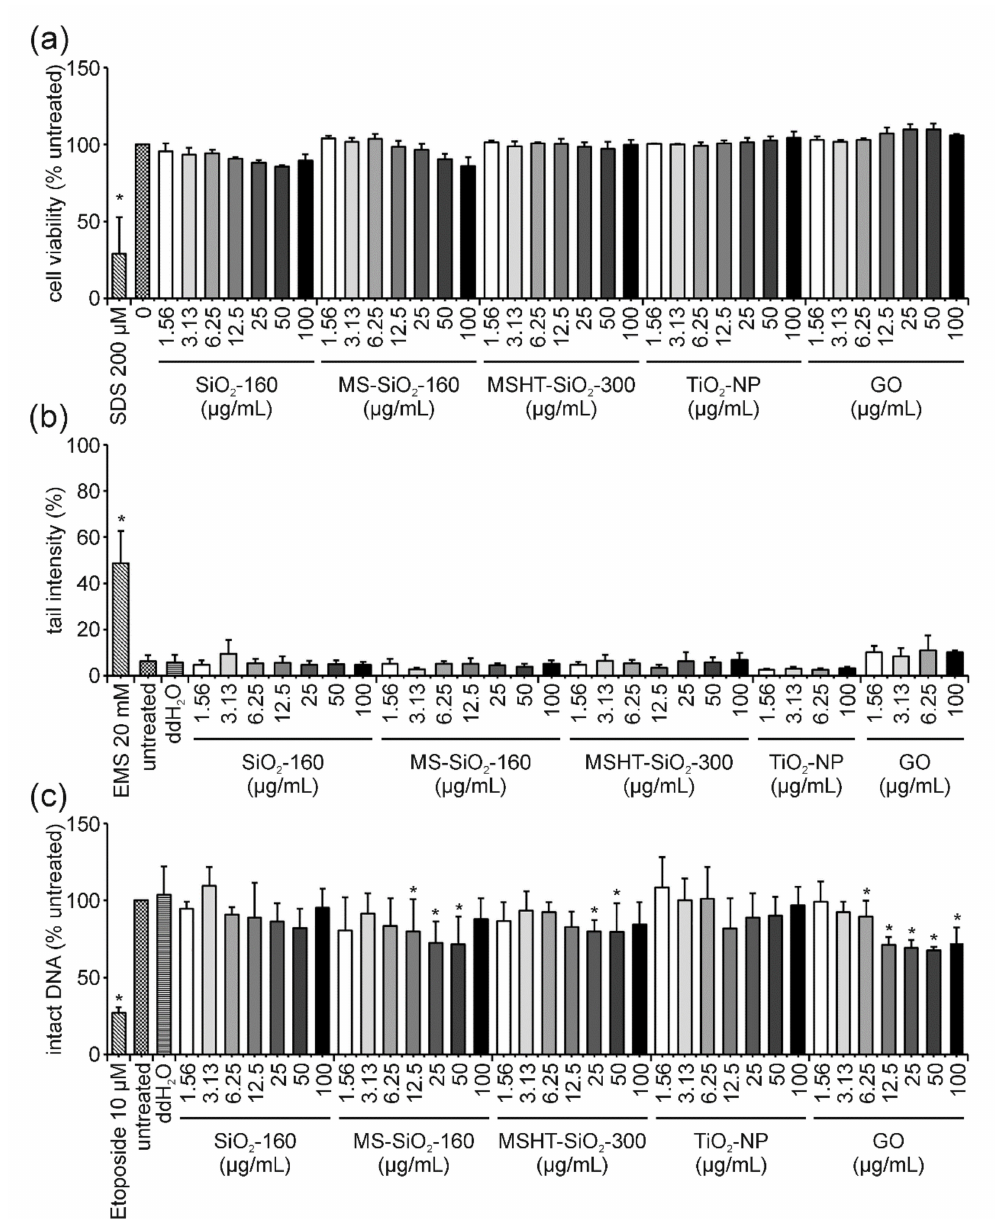
Figure 4. Influence of SiO 2 -160, MS-SiO 2 -160, MSHT-SiO 2 -300, TiO 2 -NP and GO on Jurkat E6-I cell viability and DNA damage induction after 24 h of incubation . Following incubation of Jurkat E6-I cells with different concentrations of SiO 2 -160, MS-SiO 2 -160, MSHT-SiO 2 -300, TiO 2 -NP and GO for 24 h, cell viability was determined by MTT assay ( a ). As a positive control, cells were incubated with 200 µ M SDS (24 h). DNA damage expressed as tail intensity percentage was assessed by alkaline comet assay ( b ). EMS (30 min) served as the positive control. The FADU assay was performed as a second method for genotoxicity assessment ( c ). Treatment with etoposide (30 min) served as the positive control. Results represent the mean and corresponding standard deviations from at least three independent experiments. (* p ≤